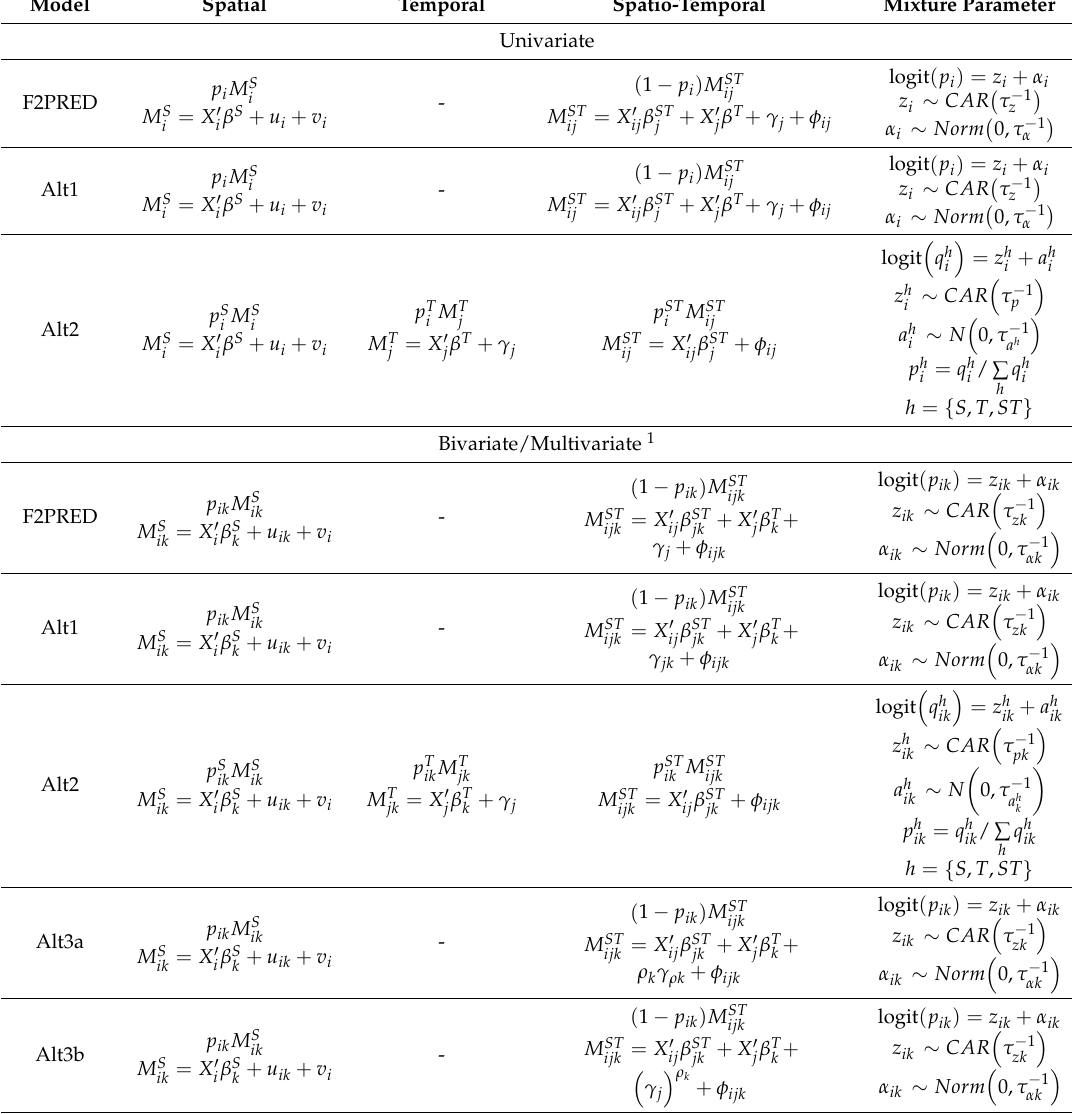
Table 2. Alternative mixture term